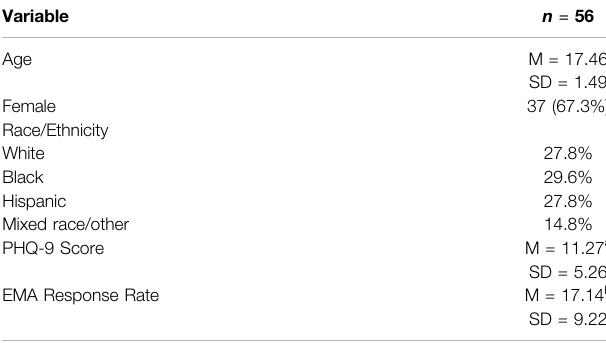
TABLE 1 | Demographic characteristics of